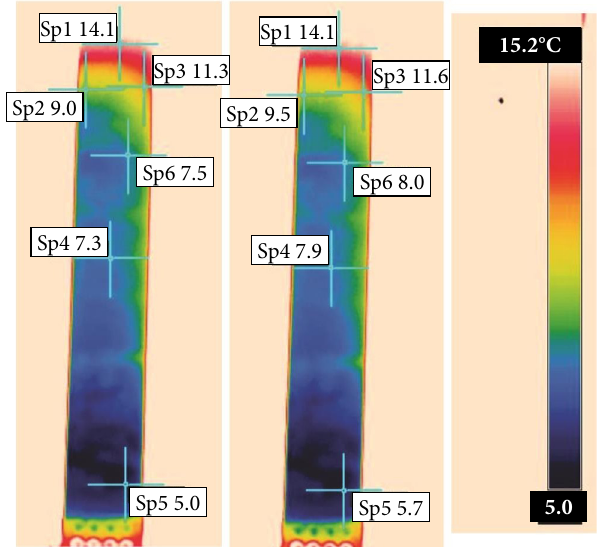
Figure 15. Infrared images in flutter